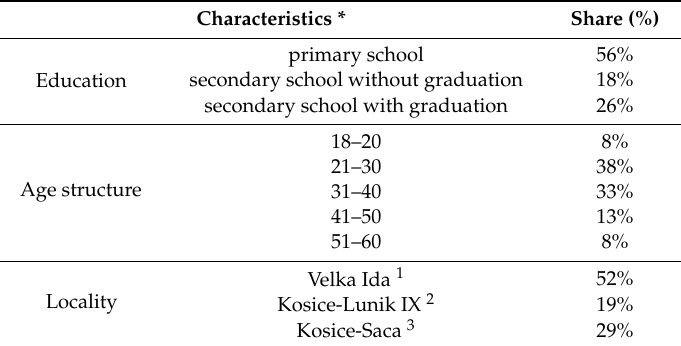
Table 3. Characteristics of the project